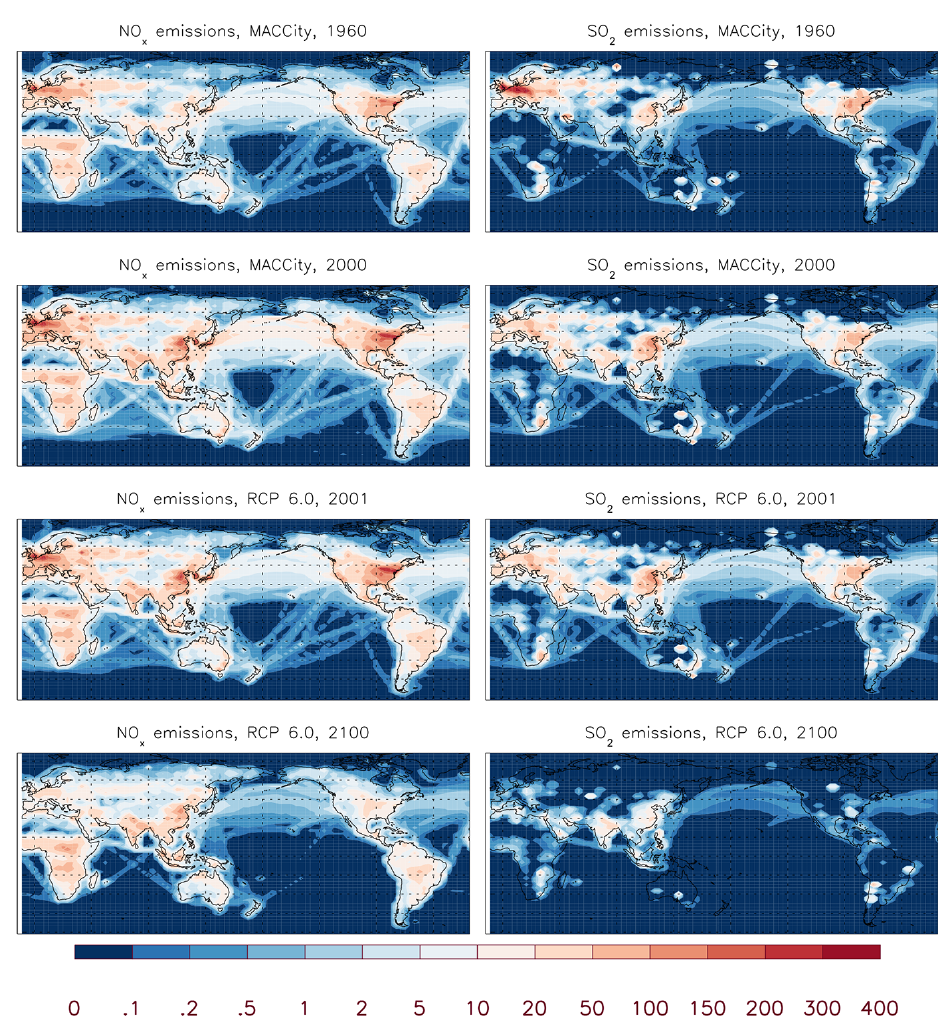
Figure 2. (left) Annual-mean NO x surface emissions (10 − 12 kg (NO 2 )m − 2 s − 1 ) in 1960 and 2000, taken from the MACCity emissions database, and in 2001 and 2100, taken from RCP 6.0. (right) Same, but for SO 2 in (10 − 12 kg (S)m − 2 s − 1 ). Displayed here are the combined surface and stack-height emissions, excluding volcanic